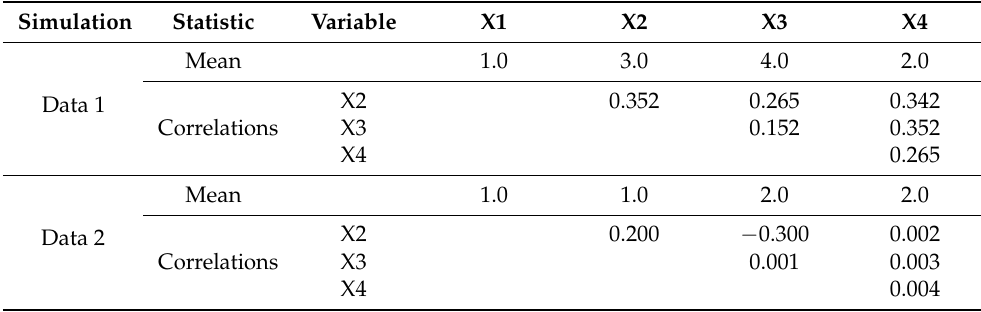
Table 3. Correlation structure for simulation